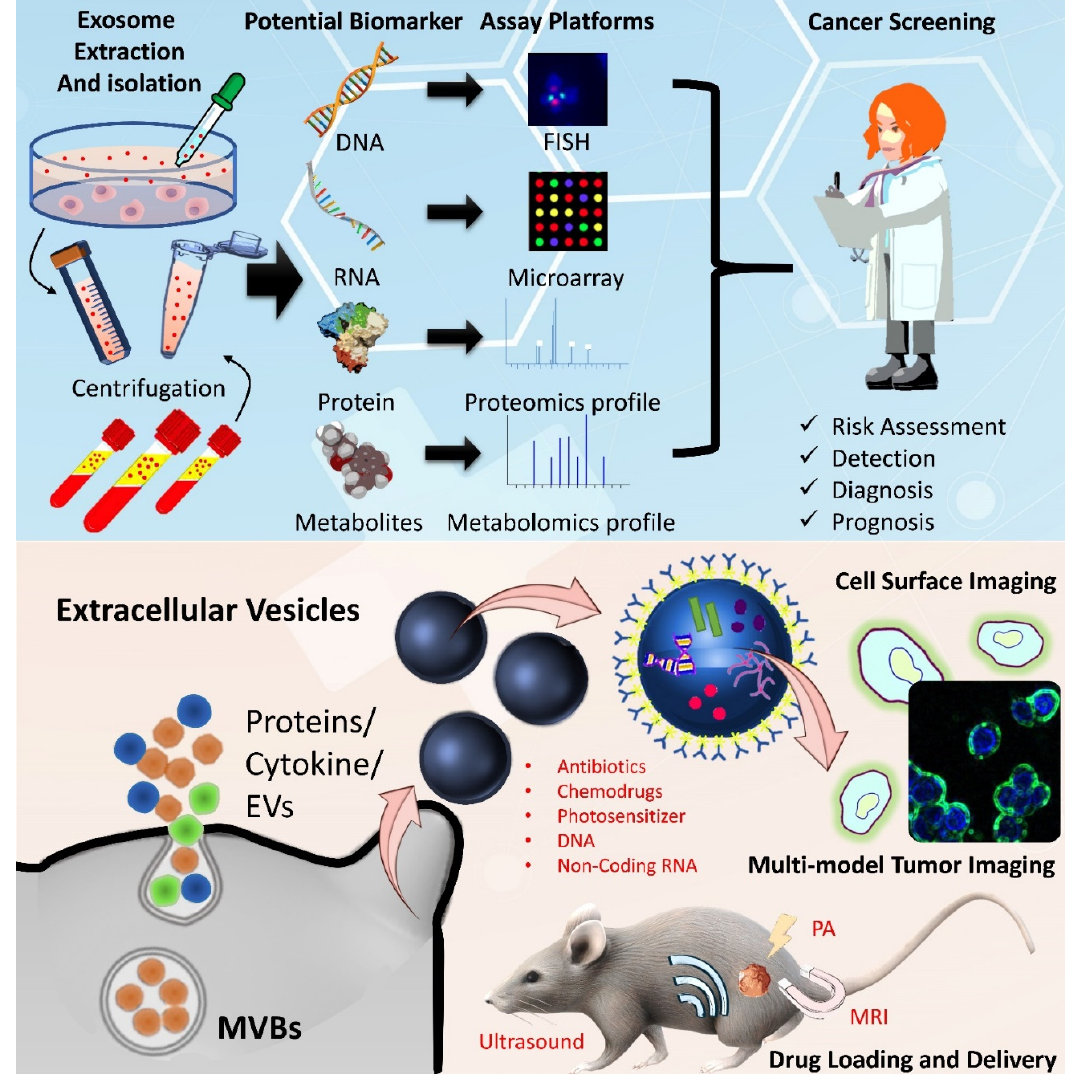
Figure 2. Current exosomal materials and application aspects. DNA, RNA, protein, and metabolites can be extracted from EVs in cancer cells, and potential clinical events (risk assessment, detection, diagnosis, and prognosis) can be analyzed. In animal models, EVs can be used to carry drugs as a strategy for biomedical imaging and therapy.